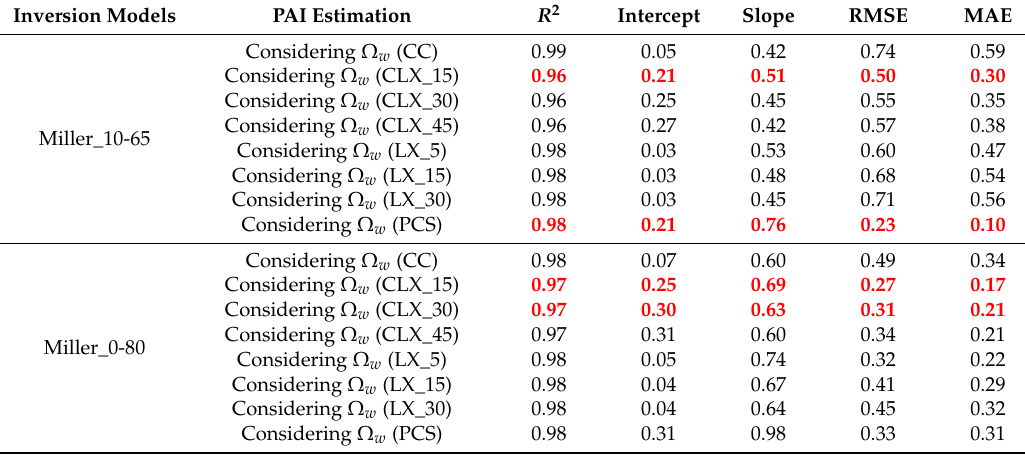
Table A2. Correlation statistics between true and estimated WAI of leaf-off deciduous forest scenes estimated from seven inversion models considering G w and Ω w . The RMSE and MAE are expressed in WAI units (m 2 /m 2